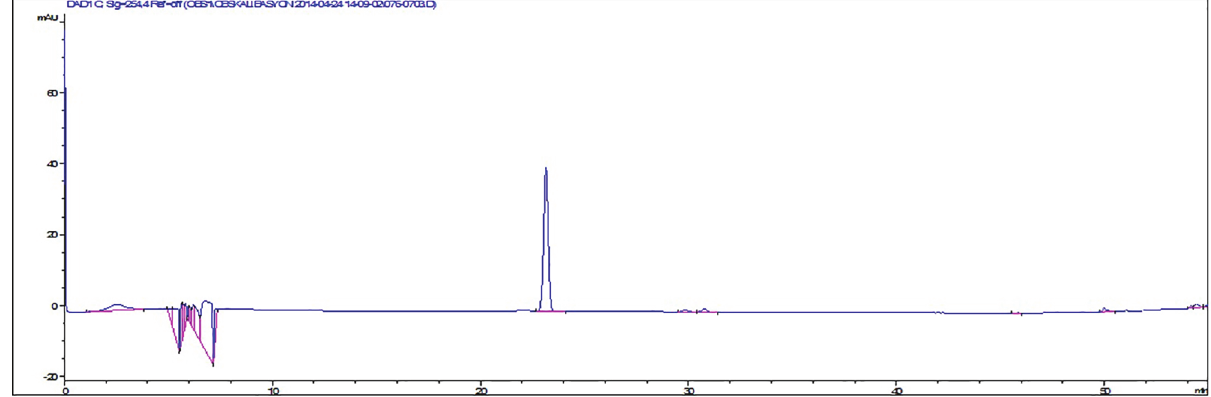
FIGURE 2 - HPLC chromatogram of rutin.